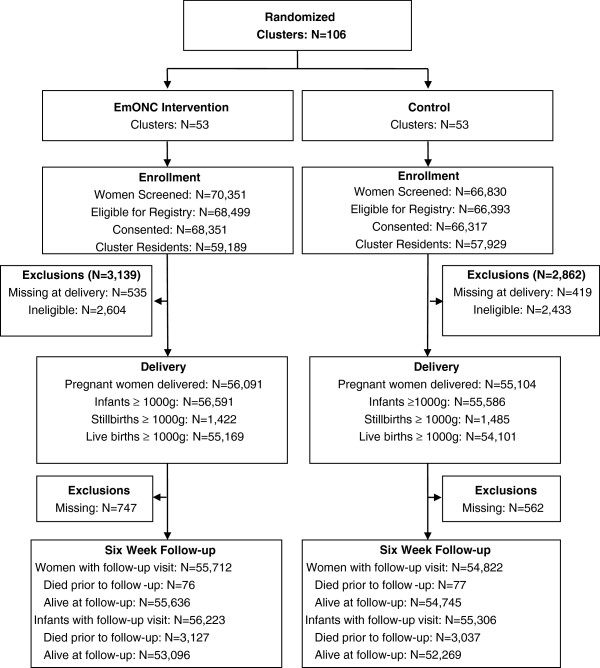
Consort diagram.